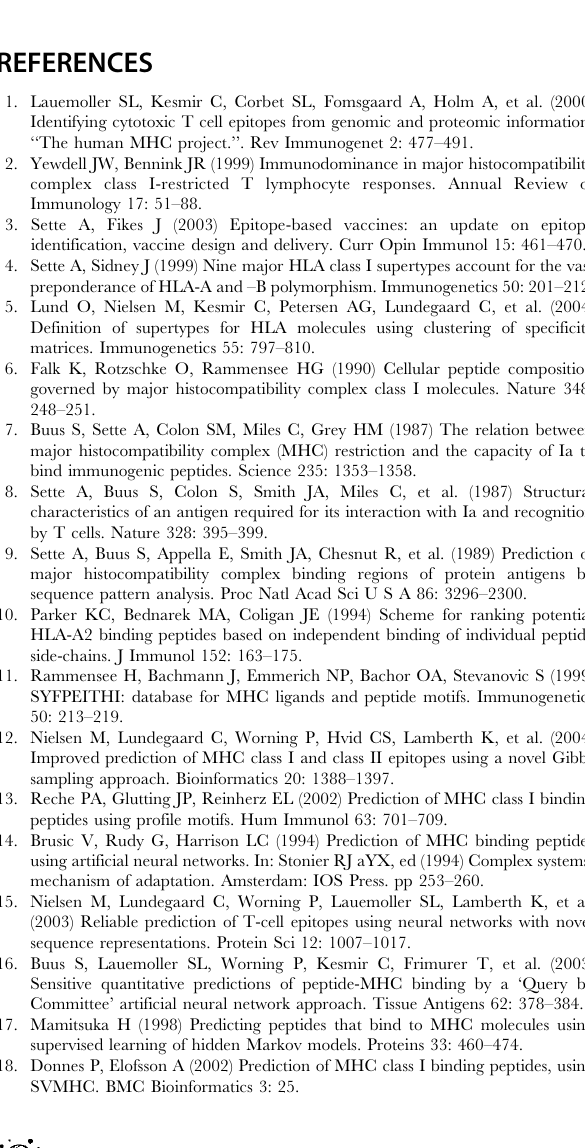
Table S3 Sensitivity and specificity relations for the NetMHC- pan method. The table displays the sensitivity and specificity values at a classification threshold of 500 nM for the NetMHCpan method as estimated from the cross validated predictive perfor- mance for the 37,384 peptide data included in the benchmark data set. The number of binding peptides is 9665. Table S4 The source data. The number of peptide binding data for each of the 24 HLA-A and 18 HLA-B